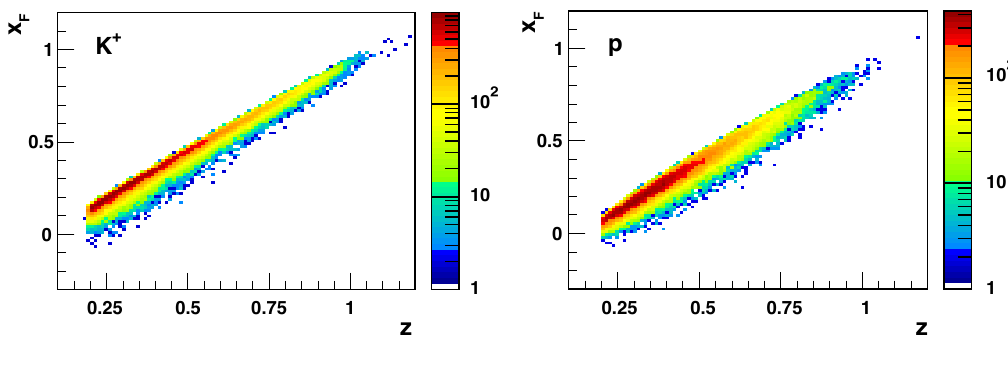
Figure 41 . Distributions in x F vs. z of the K + (left) and proton (right)